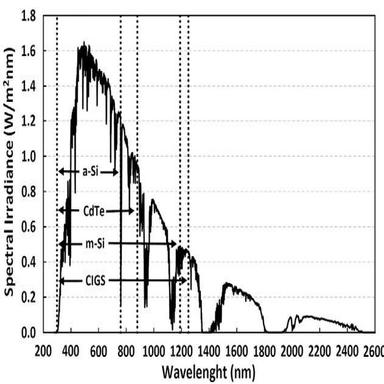
Spectral absorption band of different types of PV materials compared to the standard global spectrum.